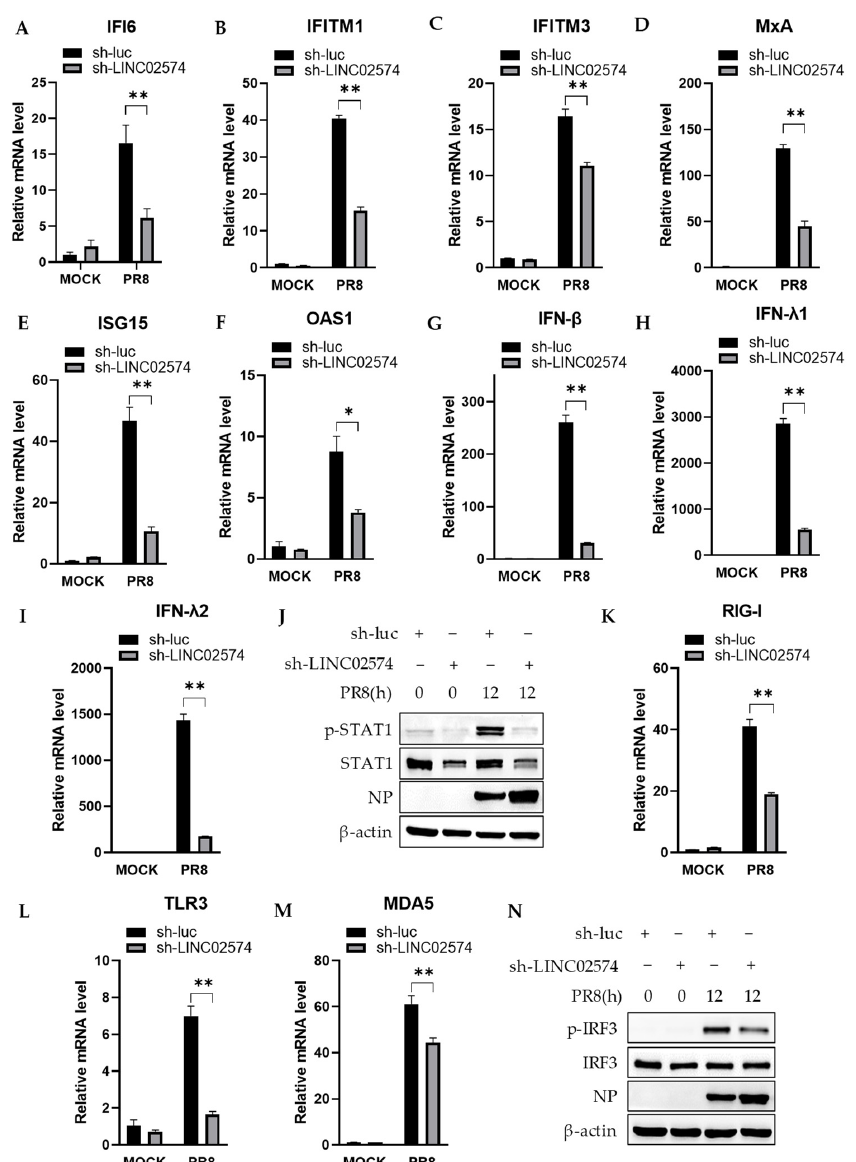
Figure 6. LINC02574 knockdown attenuates the innate immune response to influenza virus. ( A – N ) A549 cells stably expressing specific shRNAs targeting LINC02574 or luciferase control were infected with PR8 virus for 24 h. After infection, the mRNA expressions of IFI6 ( A ), IFITM1 ( B ), IFITM3 ( C ), MxA ( D ), ISG15 ( E ), OAS1 ( F ), IFN- β ( G ), IFN- λ 1 ( H ), IFN- λ 2 ( I ), RIG-I ( K ), TLR3 ( L ), MDA5 ( M ) were detected by qRT-PCR. The phosphorylation levels of STAT1 ( J ) and IRF3 ( N ) were examined by Western blotting. Data are represented as mean ± SD; n = 3; * p < 0.05, ** p <